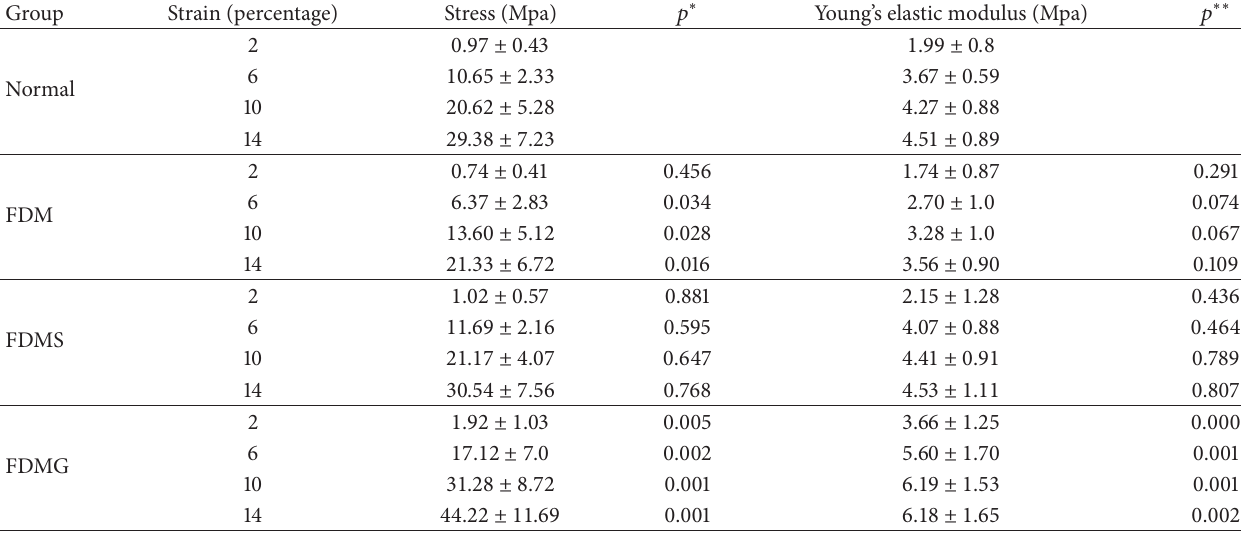
Table 3: The comparison of stress and Young’s elastic modulus between FDM, FDMS, FDMG, and normal control group, respectively (one- way ANOVA with Bonferroni correction).